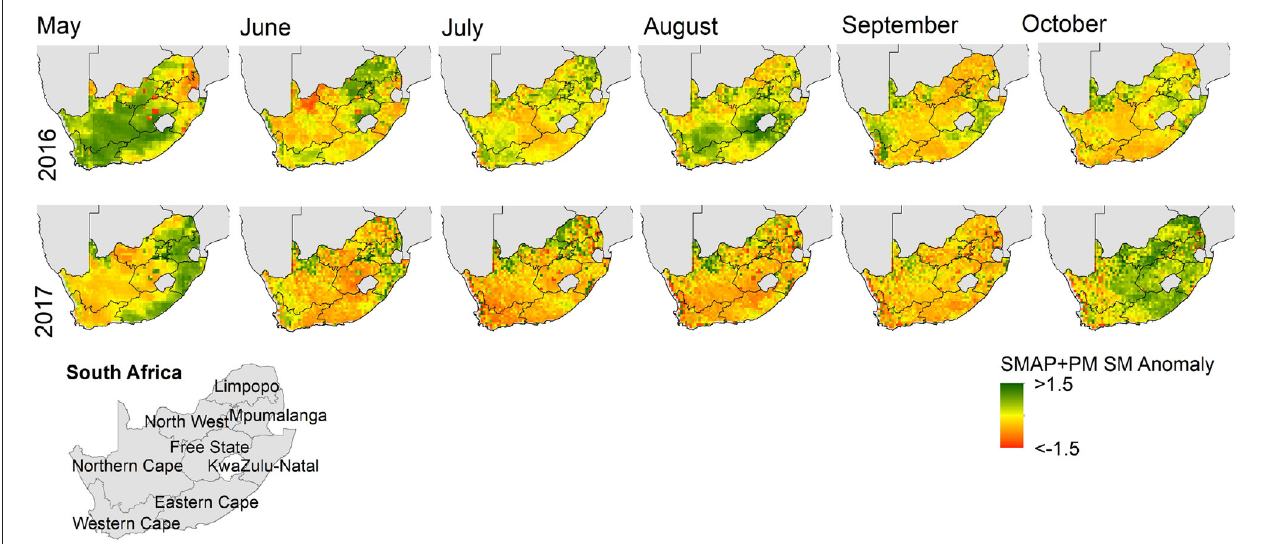
FIGURE 6 | Monthly root-zone soil moisture anomaly conditions over South Africa during the 2016 and 2017 growing seasons (May–October). Each value shows the deviation of the current conditions relative to the long-term average standardized by the climatological standard deviation. Negative values indicate that the current conditions are below average, while positive indicate surplus of